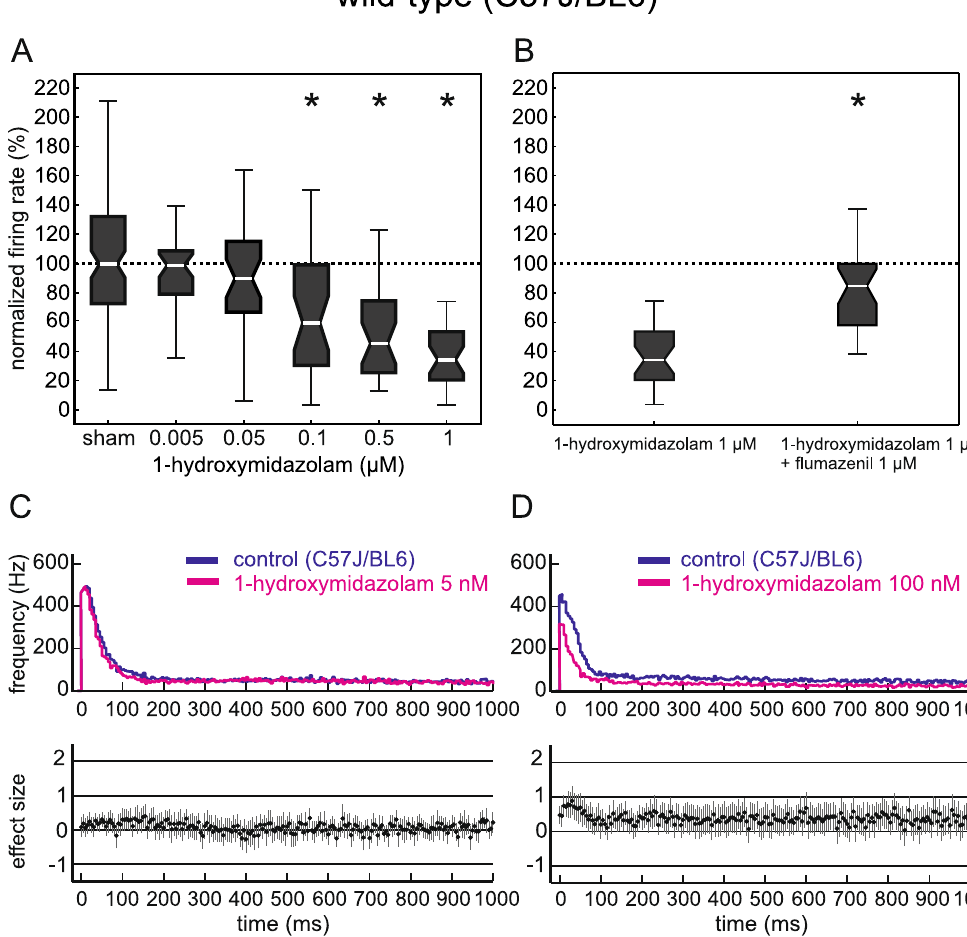
Figure 3. Effects of 1-hydroxymidazolam in neocortical slice cultures from wild-type mice. ( A ) Effects of 1-hydroxymidazolam on cortical network activity. 1-hydroxymidazolam did not induce significant changes in the neuronal action potential firing rate at low concentrations (5 nM and 50 nM). Only at concentrations ranging from 100 nM to 1 μ M a significant inhibition of the action potential firing rate could be observed. Note that the depressing effect steadily rose by increasing the concentration of 1-hydroxymidazolam ( * p < 0.001; Kruskal-Wallis test, post-hoc analysis (Bonferroni) followed by Mann-Whitney U test). ( B ) Actions of 1-hydroxymidazolam in the presence of the benzodiazepine antagonist flumazenil. Left box plot shows the normalized firing rate of 1 μ M 1-hydroxymidazolam, right box plot shows the normalized firing rate after the combined application of 1 μ M 1-hydroxymidazolam and 1 μ M flumazenil ( * p < 0.001). ( C ) PETH showing the effects of 5 nM 1-hydroxymidazolam (magenta, n = 34) versus control condition (dark blue). Unlike midazolam, 1-hydroxymidazolam did not depress neuronal activity during up states at low concentrations. For the effect of midazolam at the corresponding concentration please see Fig. 1C. ( D ) Actions of 100 nM 1-hydroxymidazolam (magenta, n = 34), versus control condition (dark blue) given as